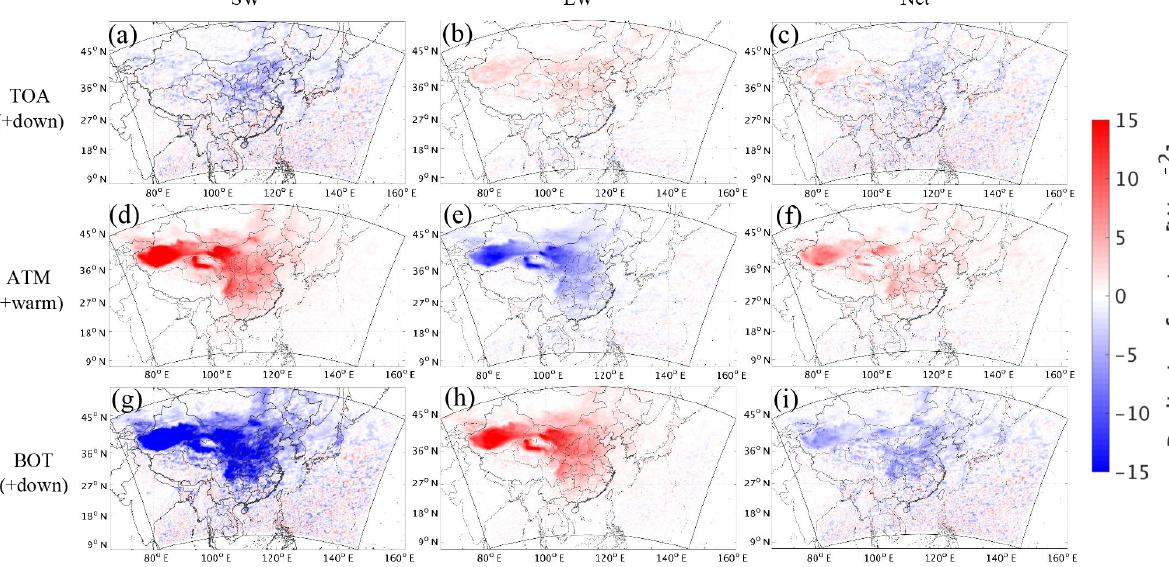
is − 0.63 W m − 2 at the top of the atmosphere, − 2.19 W m −